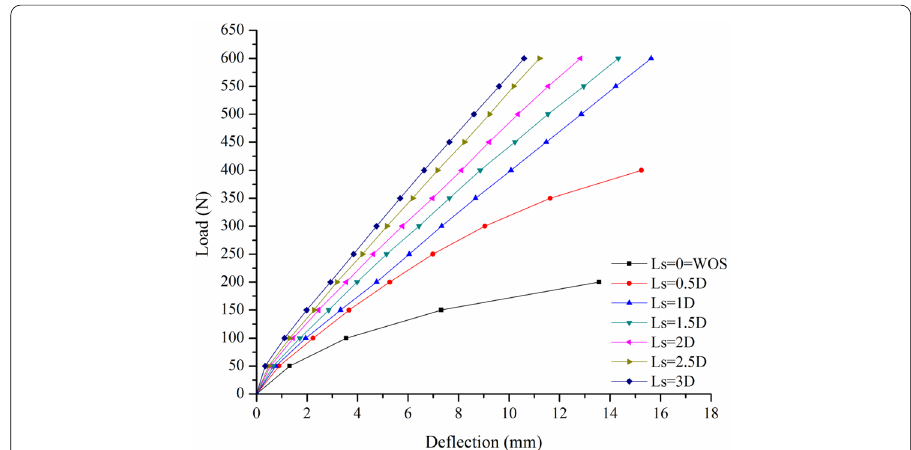
Fig. 6 Lateral load defection behavoiur of 50.8 mm diameter pile with embedded depth of 600 mm (L